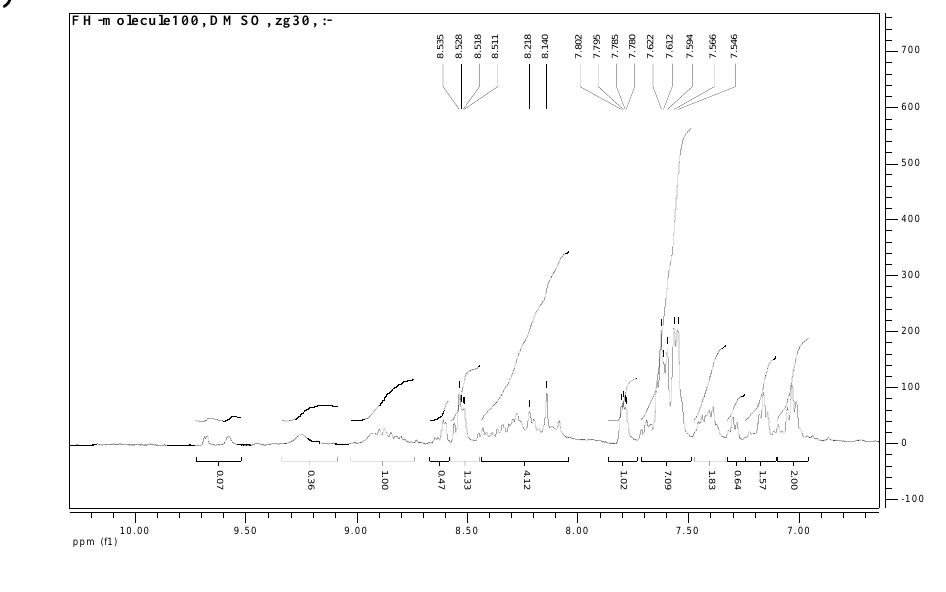
Figure 2. 1 H-NMR spectra of complex [RuL L (NCS) ] complex; (b) aliphatic region 1 H-NMR spectrum of spectrum of [RuL 1 2 2 L (NCS) ] complex. [RuL 1 2 2